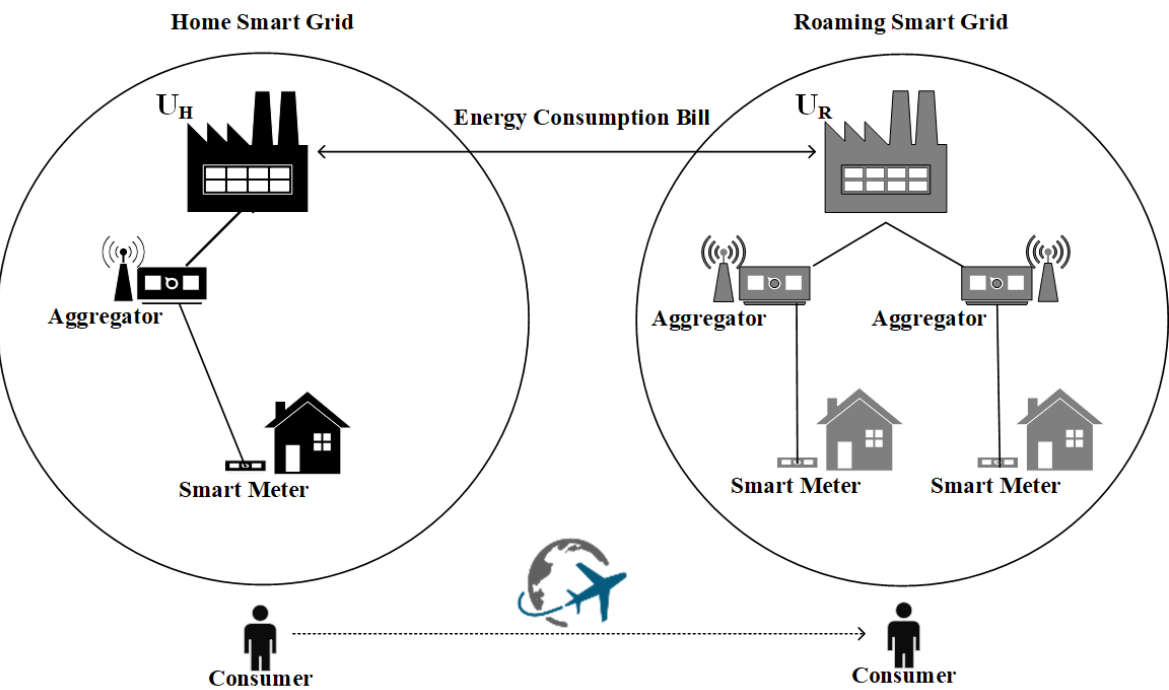
Figure 1. Relation between the P4G2Go entities.